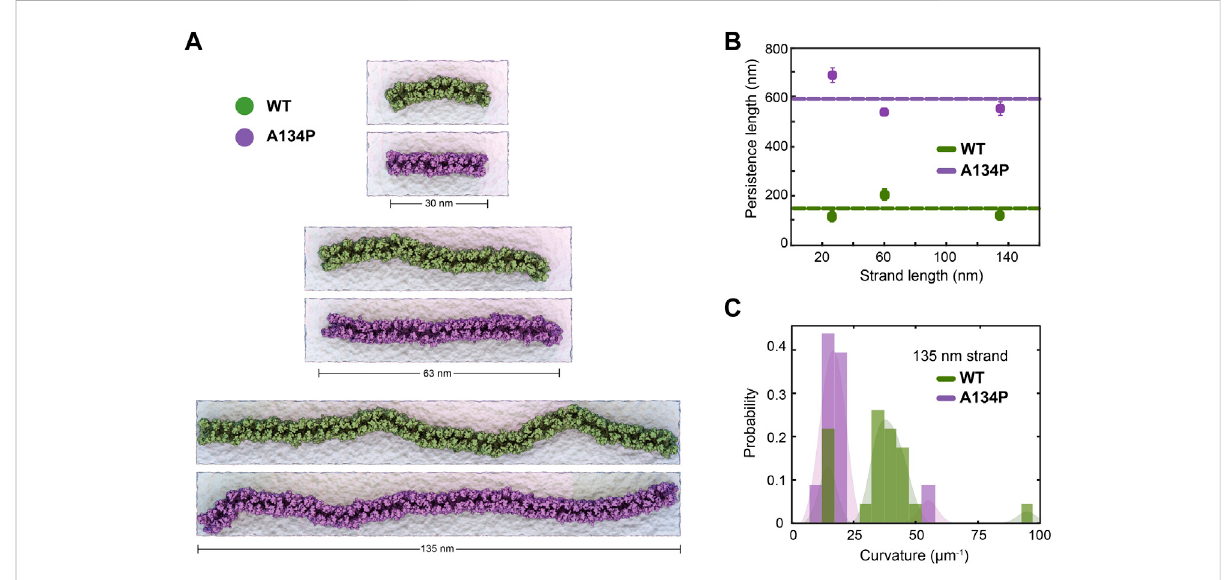
FIGURE 2 TM3 bending restrict claudin-15 strand fl exibility. (A) Equilibrated con fi guration of WT and A134P strands of variouslengths simulated for 1 μ s in double parallel lipid bilayers and hybrid resolution, show the “ curvy ” morphology of cluadin-15 strands as opposed to the more “ straight ” shapes of A134Pmutantstrands. (B) ThestrandpersistencelengthiscalcualatedforeachlengthofWTandA134Pclaudin-15strands.Thehorizontallinesshow the average persistence length for WT and A134P mutant strands. (C) The distribution of local curvature along the length of the longest simulated strand (135 nm) is calculated for WT and A134P